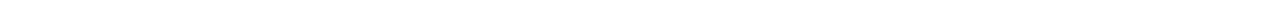
Fig. 5 Reactivation of WNT pathway supports MYC-induced stem cell features. a qRT-PCR of WNT pathway-related genes on IMEC WT, IMEC-MYC, and M2 clones #1 and #2, normalized on spike-in RNAs. Data are means ± SEM ( n = 3) (* P < 0.05, ** P < 0.01, *** P < 0.001; Student ’ s t- test). b FACS analysis showing the GFP signal of IMEC-MYC-7TGP cultured in adhesion or as mammospheres. c On the left, phase contrast images showing IMEC-MYC-7TGP cultured in low adhesion conditions. Scale bar, 100 µ m. On the right, FACS analysis showing GFP signal and dye retention pro fi le of IMEC-MYC-7TGP cultured in low adhesion conditions. d Scheme representing GFP high and GFP low cells sorting from IMEC-MYC-7TGP, which gave rise to GFP high - and GFP low -derived 1° Spheres (M1). GFP high -derived 1° Spheres underwent a second single-cell sorting of GFP high and GFP low cells, which gave rise to GFP high - and GFP low -derived 2° Spheres (M2). Representative FACS analysis showing GFP signal and median fl uorescence intensity (MFI) of sorted IMEC-MYC- 7TGP and GFP high -derived M1 clones are reported. e On the left, single-cell spheres formation ef fi ciency (SFE) of GFP high and GFP low cells sorted from IMEC-MYC-7TGP, which gave rise to M1 clones. MFI of GFP high - and GFP low -derived M1 clones is reported. On the right, single-cell SFE of GFP high and GFP low cells sorted from GFP high -derived M1, which gave rise to M2 clones. MFI of GFP high - and GFP low -derived M2 clones is reported. Data are means ± SEM ( n = 4). f GSEA of mammary stem cells (MaSCs) gene signature in freshly sorted GFP high and GFP low cells ( n = 3). g GSEA of lung, bone, and brain metastatic signatures in freshly sorted GFP high and GFP low cells ( n =